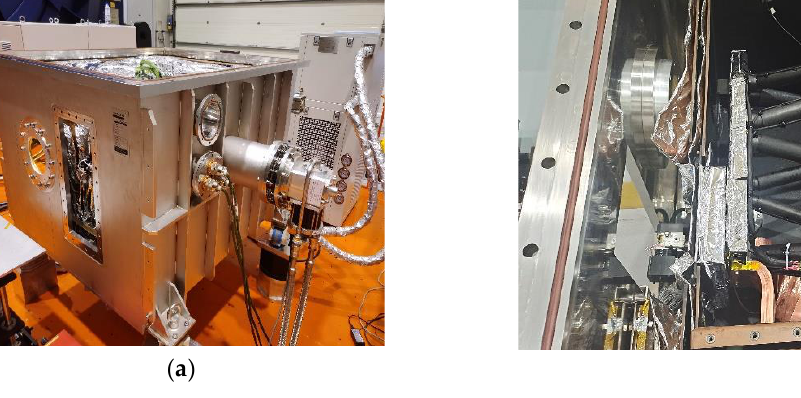
Figure 14. ( a ) A schematic diagram of the cryogenic vacuum chamber; ( b ) A layout of the inner cryogenic vacuum chamber.